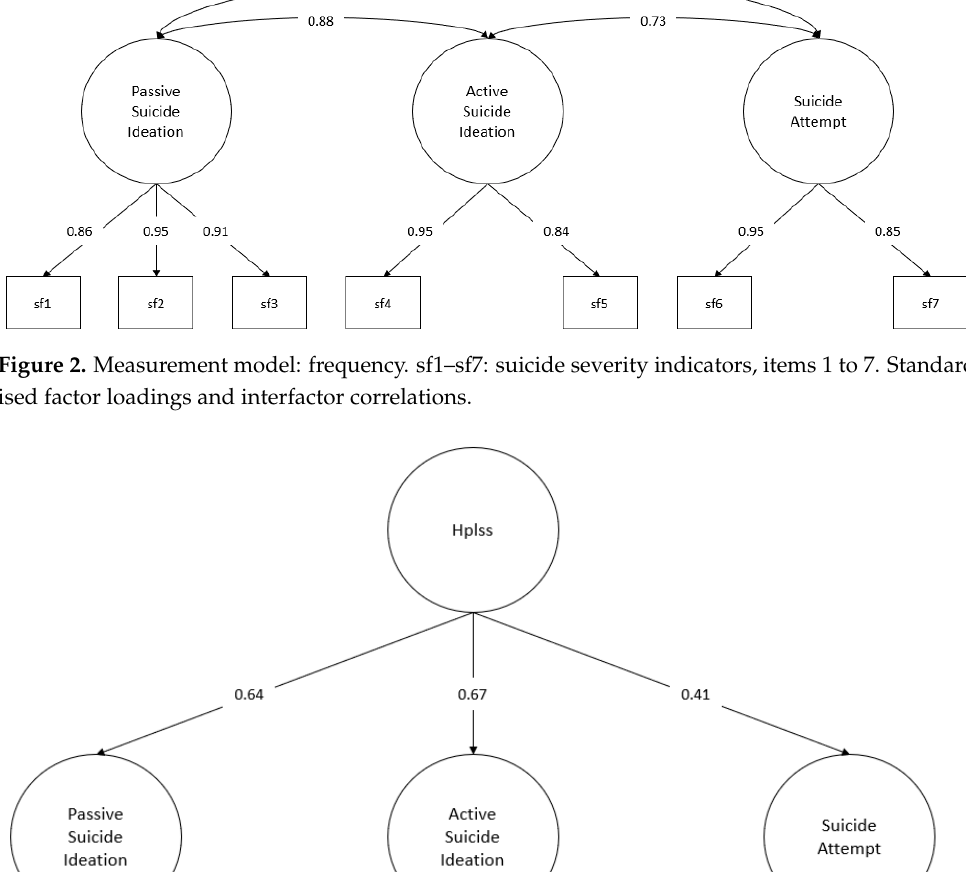
Figure 2. Measurement model: frequency. sf1–sf7: suicide severity indicators, items 1 to 7. Stand- ardised factor loadings and interfactor correlations.